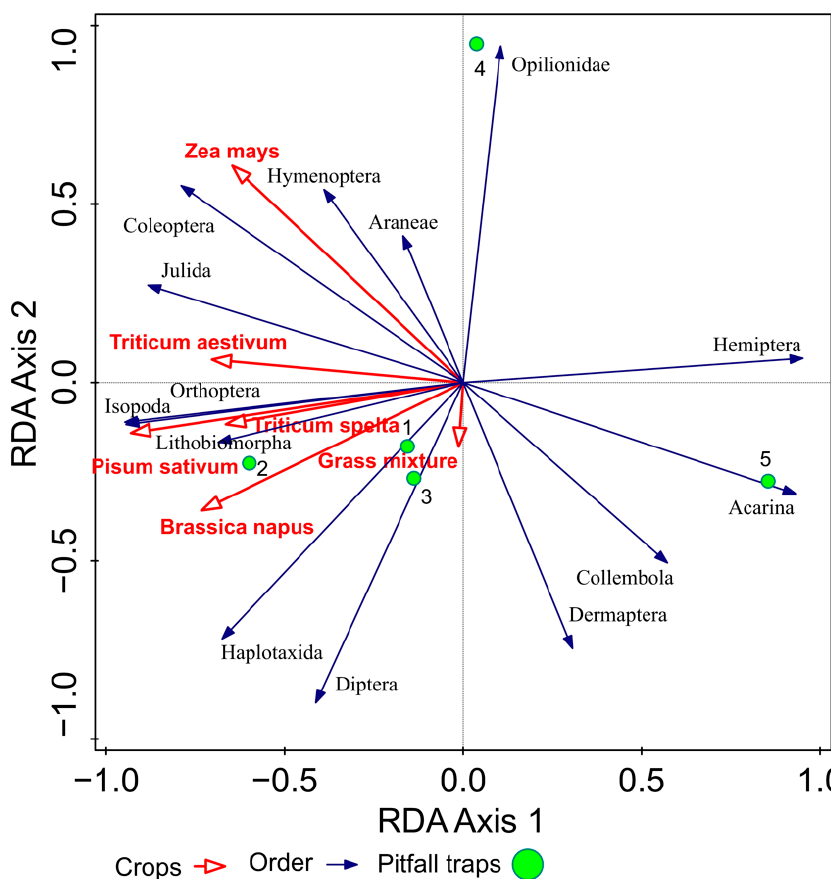
Figure 4. RDA (redundancy analysis) analysis of arthropods with respect to crops.